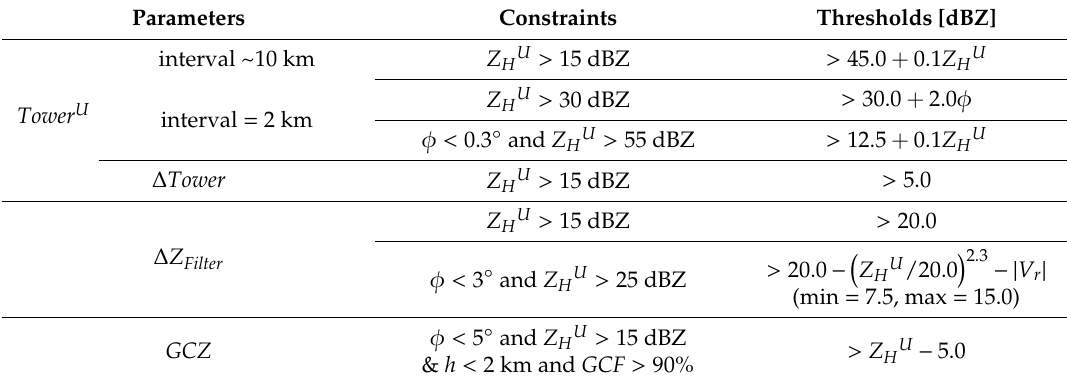
Table 2. Feature parameters and identification conditions for ground